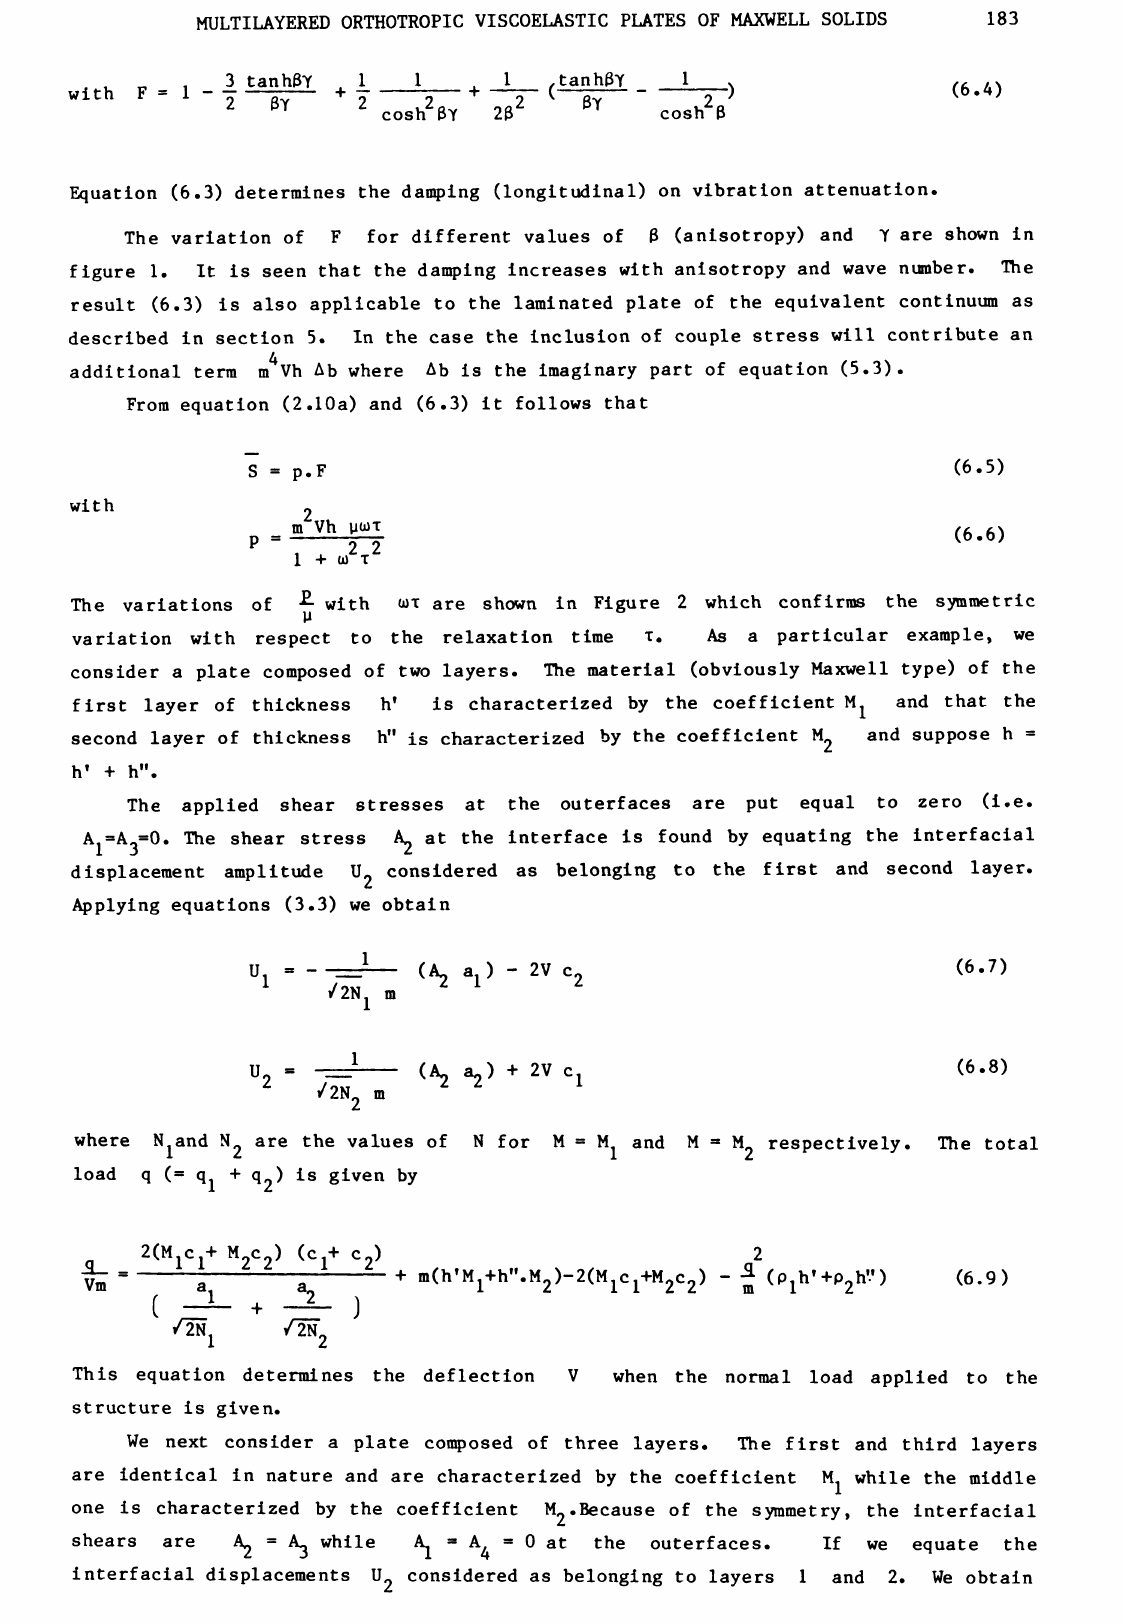
figure I. It is seen that the damping increases with anisotropy and wave number. The result (6.3) is also applicable to the laminated plate of the equivalent continuum as described in section